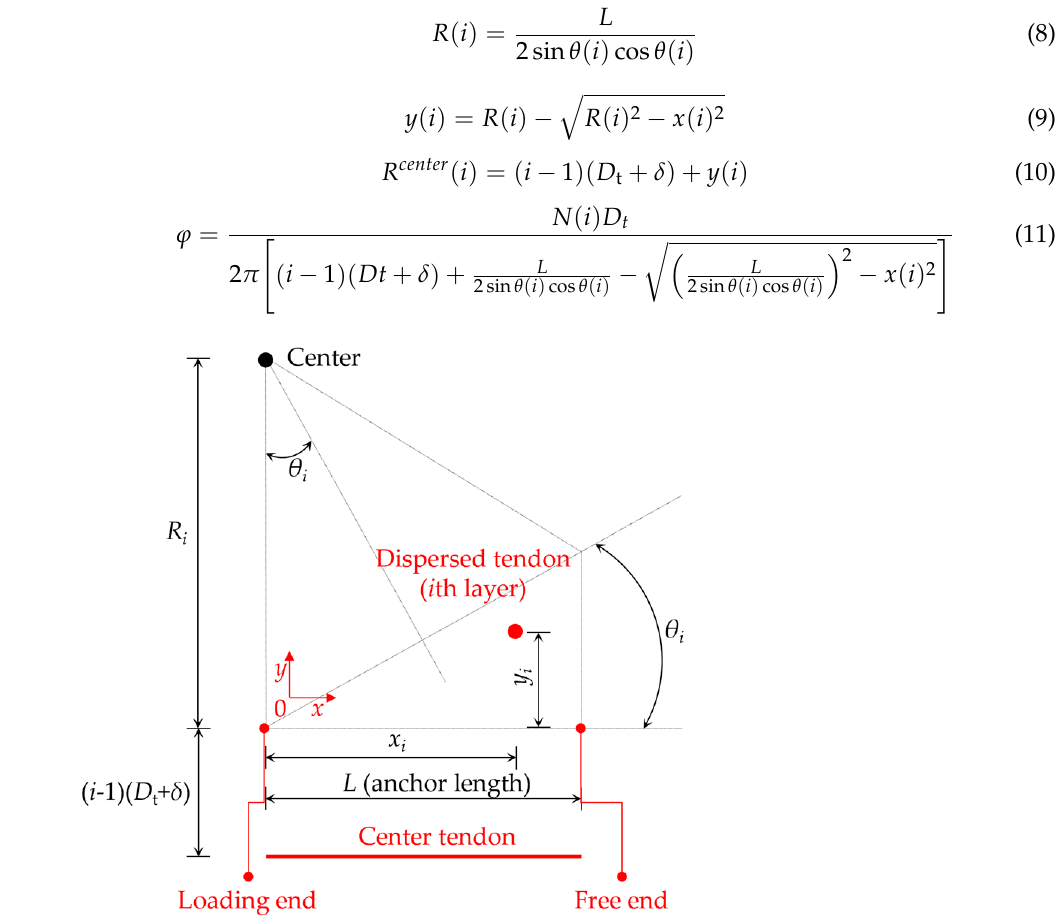
Figure 6. Geometric relation of dispersed tendons.